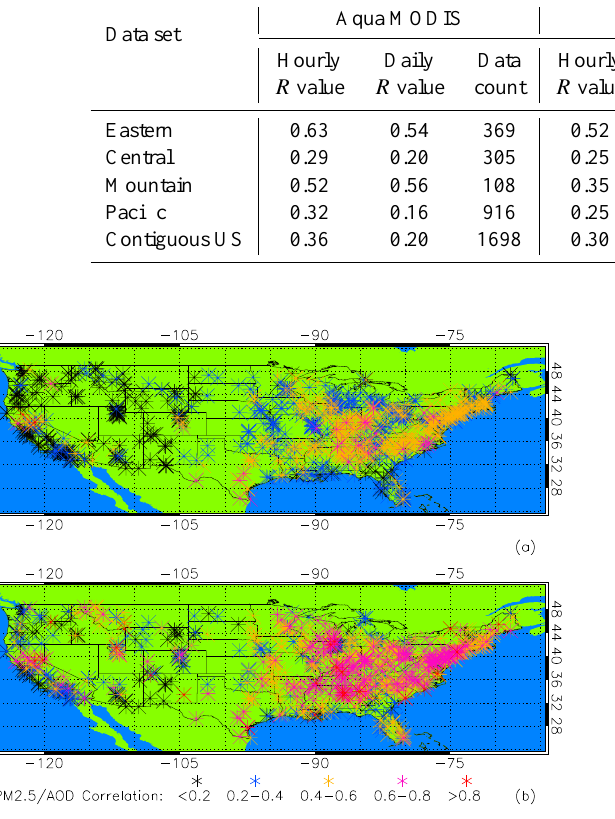
Figure 5. For the period 2008–2009, the US EPA daily PM 2 . 5 sites used in this study. Sites are color-coded based on the correlation between daily PM 2 . 5 observations and daily 1 ◦ × 1 ◦ (a) operational and (b) DA MISR